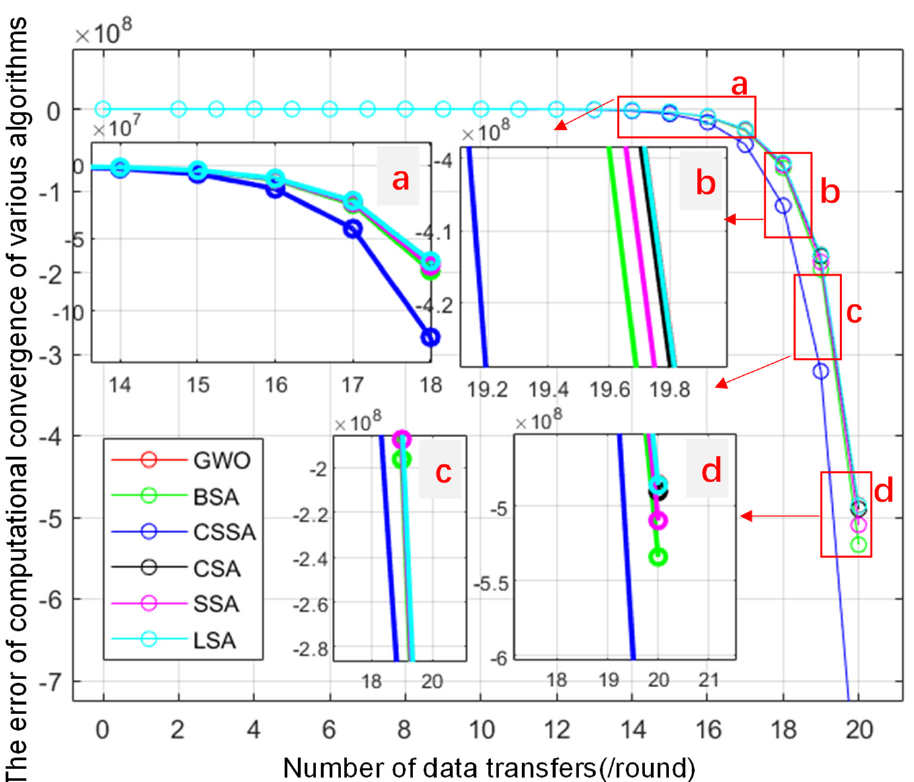
Figure 3. Performance comparison of different algorithms. ( a ) Beginning of the convergence method. ( b ) Enlarged view of rapid convergence. ( c ) Enlarged view of the maximum convergence speed node. ( d ) Enlarged view of the end of convergence of some nodes.